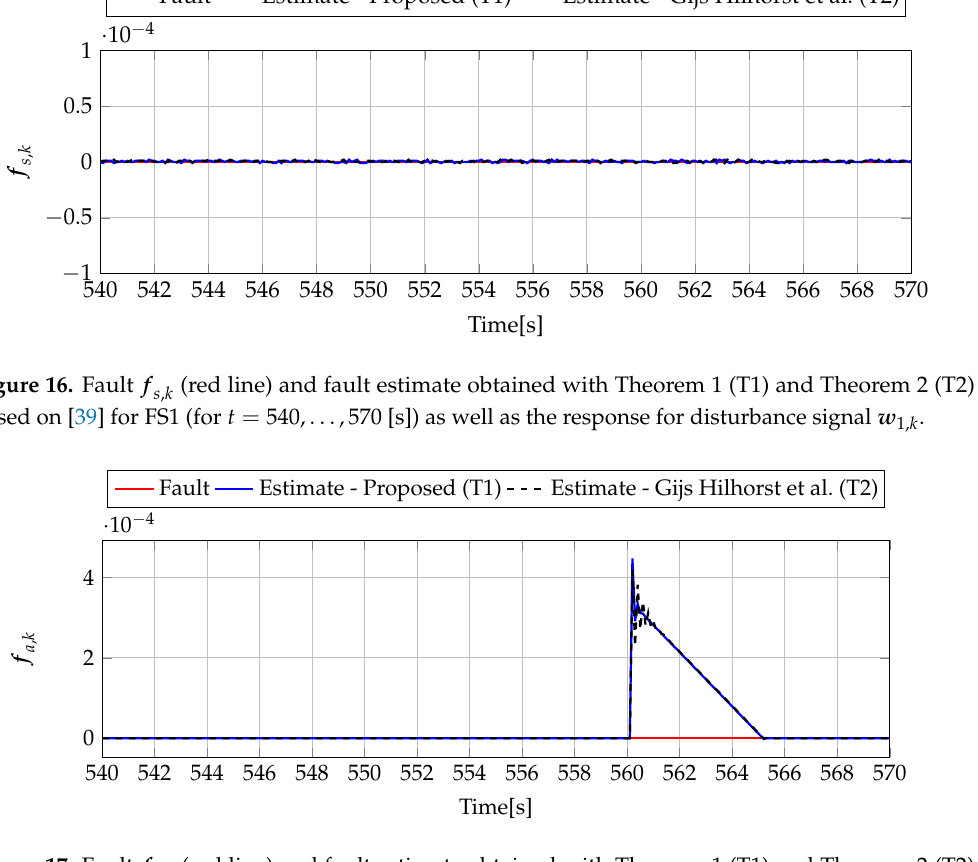
Figure 17. Fault f (red line) and fault estimate obtained with Theorem 1 (T1) and Theorem 2 (T2) a , k based on [39] for FS2 (for t = 540, . . . ,570 [s]) as well as the response for disturbance signal w 1, k